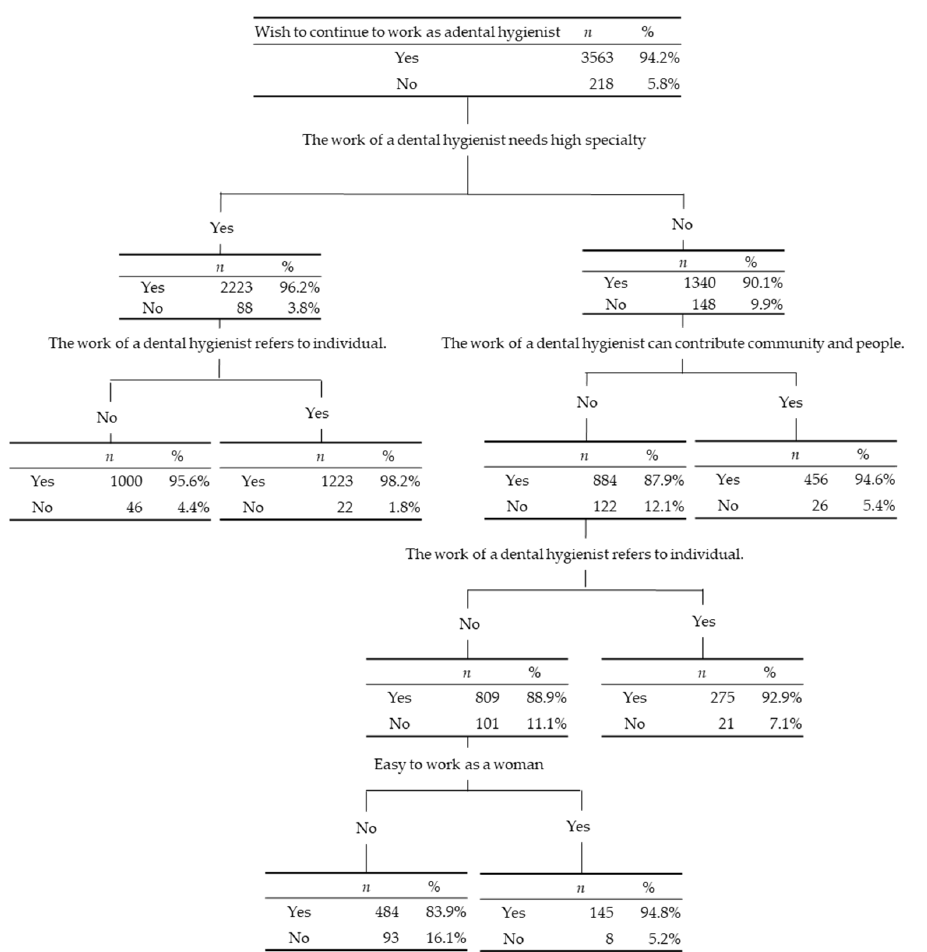
Figure 4. Decision analysis to determine the dental hygienists who answered “no” to “Do you wish to continue working as a dental hygienist?”